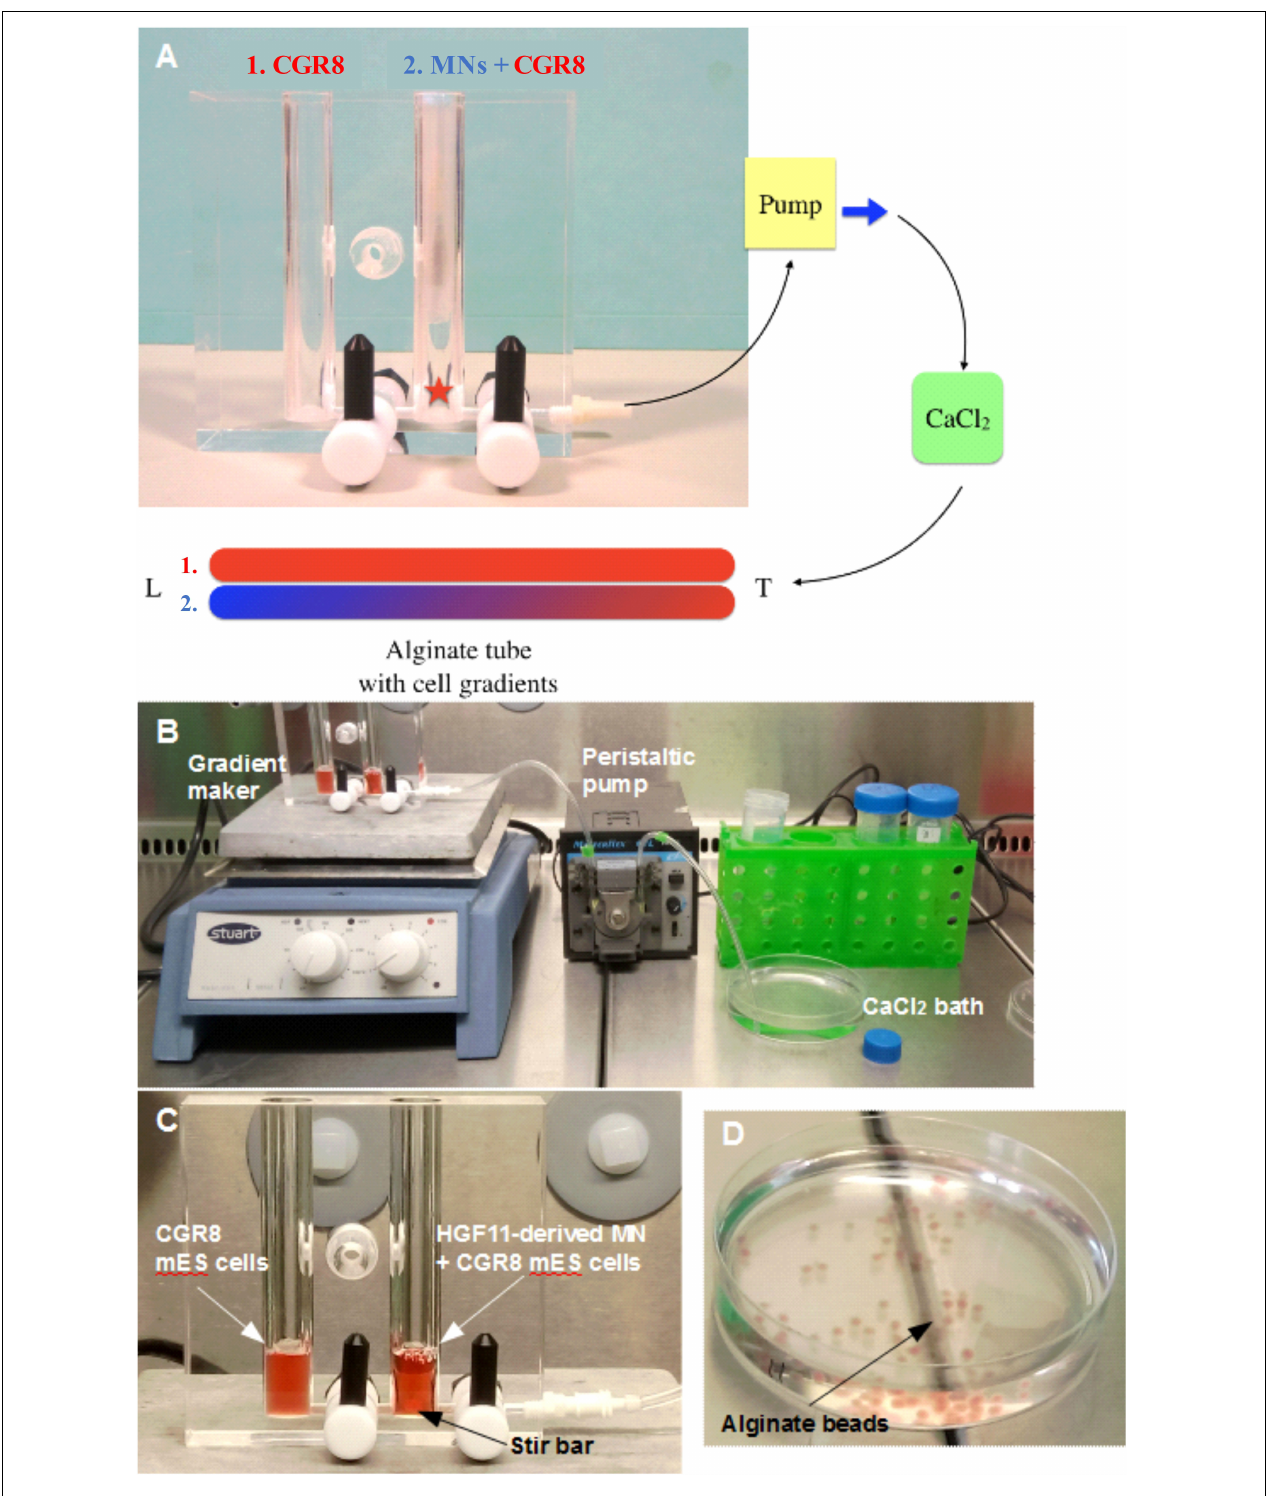
FIGURE 1 | Formation of alginate beads and fibers (tubes). (A) The gradient is formed from two alginate: cell solutions: 1. (in red) alginate containing CGR8 ESCs only, and 2. (in blue/red) alginate containing CGR8 ESCs and HGF11 ESC-derived MNs. An equal volume of alginate solutions 1 and 2 are added to chambers 1 and 2, respectively (MN: HGF11-derived MNs, CGR8: wildtype ESCs, Red star: location of stir bar). (B) The gradient maker setup and equipment for making the alginate fibers. (C) A close-up image of the gradient maker showing the two chambers containing alginate-cell suspension solutions for forming alginate fibers. (D) Beads formed from 1 mL of alginate: cell (CGR8 ESCs) suspension by manual extrusion through a 21G needle.